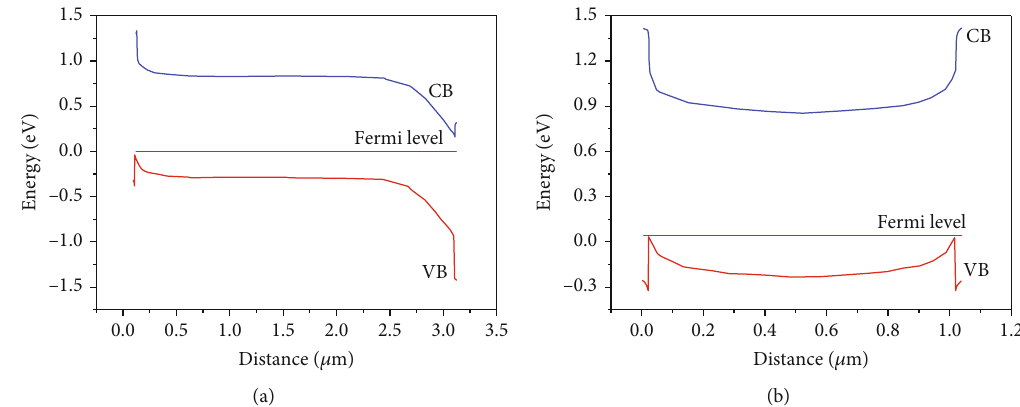
Figure 6: Energy band diagrams under equilibrium conditions obtained (a) along (from top to bottom) the wire and (b) the second for the case across the wire with a length of 3 μ m, a diameter of 1 μ m, and doping of 1015sm -3